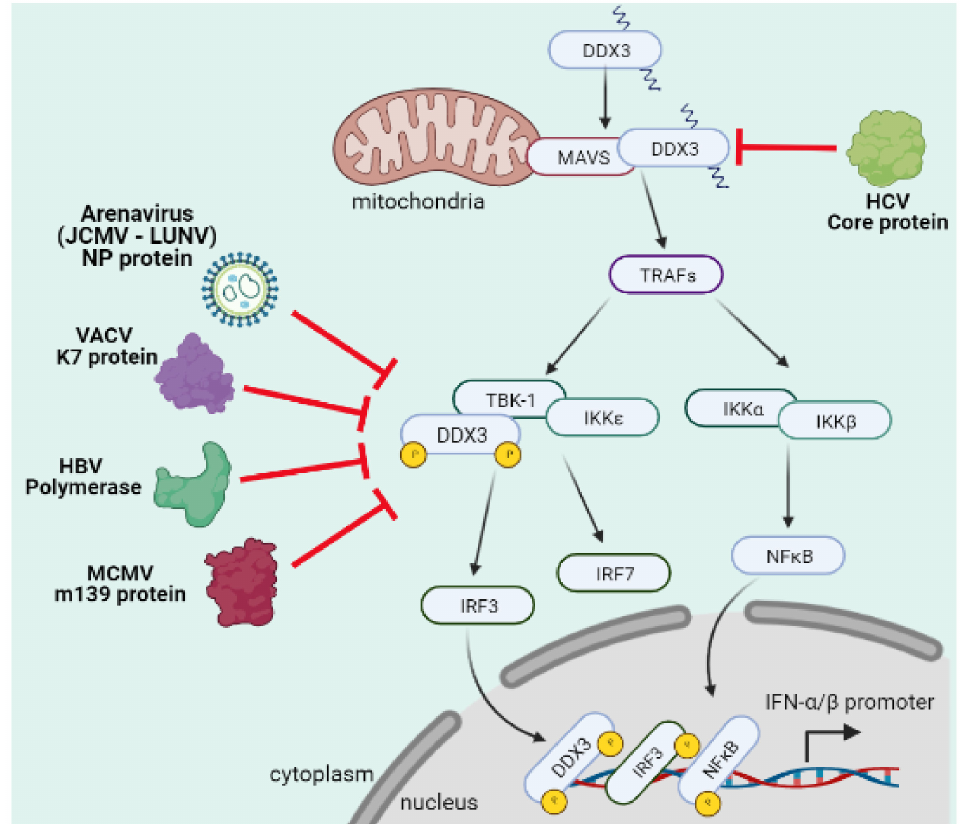
Figure 6. Distinct viral proteins block DDX3 and inhibits type-I IFN production. Arenavirus, VACV K7 protein, HBV polymerase and MCMV m139 protein are able to block interaction of DDX3 with TBK-1/IKK ε , avoiding DDX3 phosphorylation and inhibiting type I IFN production. Additionally, HCV core protein interacts with DDX3 and promotes MAVS